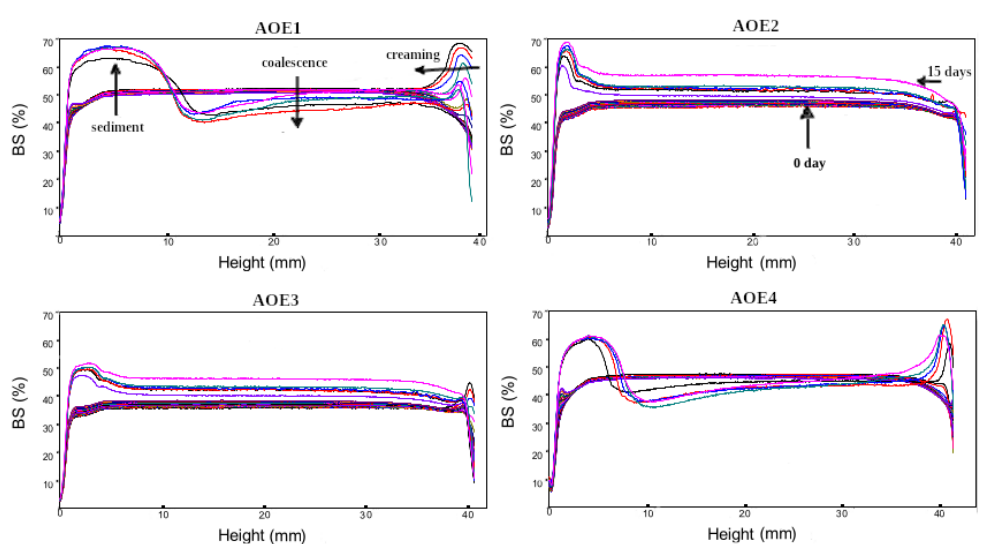
Figure 3. Backscattered light intensity as a function of the height of a measuring cell of O/W emulsions stabilized by particulate emulsifiers through fifteen days of storage at 25 ◦